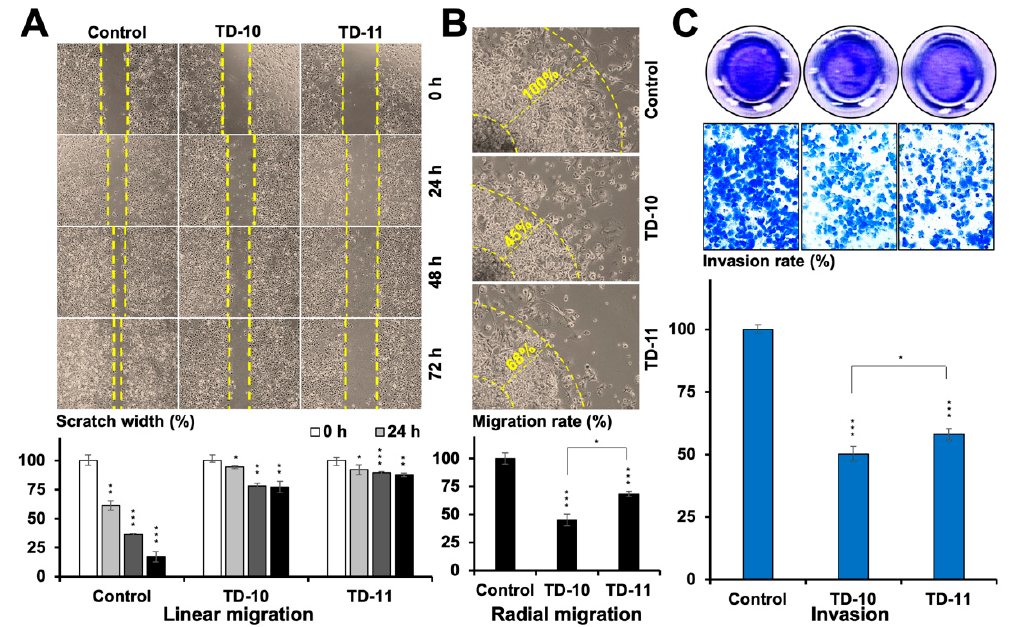
Figure 1. Anti-metastatic activity of the TEG derivatives in Panc-1 cells. ( A ) Wound scratch migration assay showed a delay in primary tumor site migration potential over a period of 72 h. ( B ) Radial migration assay showed an inhibition of the distension migration from the secondary tumor site over a period of 72 h. ( C ) Matrigel ® invasion assay showed an anti-invasive potential of the derivatives over a period of 24 h. Statistical significance was defined as p -values (*) where * < 0.05, ** < 0.01 and *** < 0.001 represent significant, very significant and highly significant, respectively.